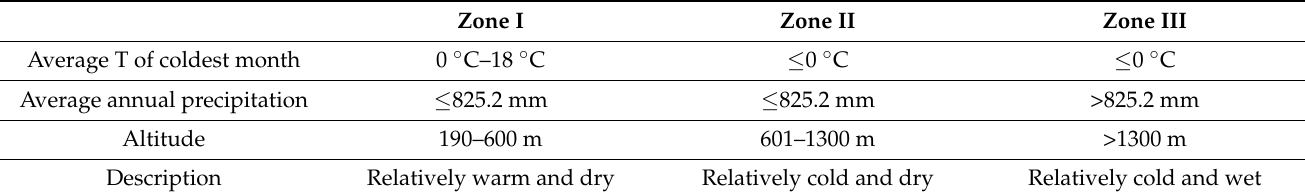
Figure 1. Climate zones of South Tyrol defined in this study. Table 1. Climate differences among climate zones in this study.